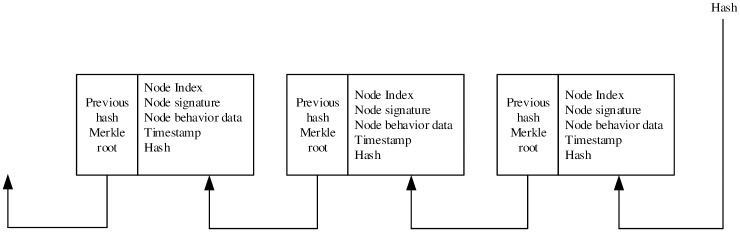
Node behavior data block structure.